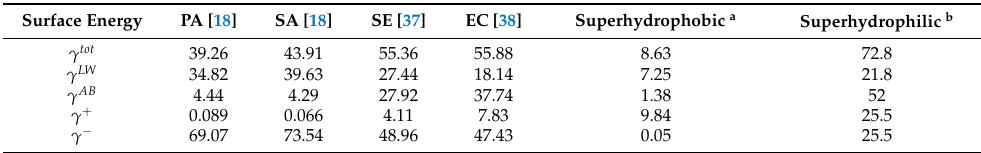
Table 5. Surface energy data used to determine Gibbs interaction energies where γ tot is the total (i.e., summative) surface energy, γ LW is the Lifshitz-van der Waals (i.e., nonpolar) surface energy component, γ AB is the acid-base (i.e., polar) surface energy component, γ + is the acid surface energy component, and γ − is the base surface energy